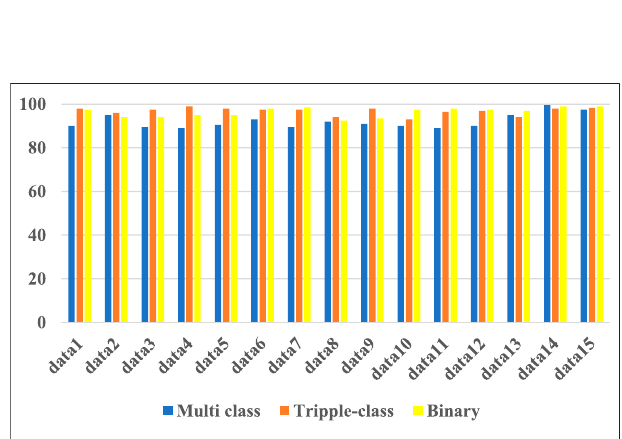
FIGURE 8 | Accuracy across 15 multiple-class, 15 trinary-class, and 15 binary datasets.